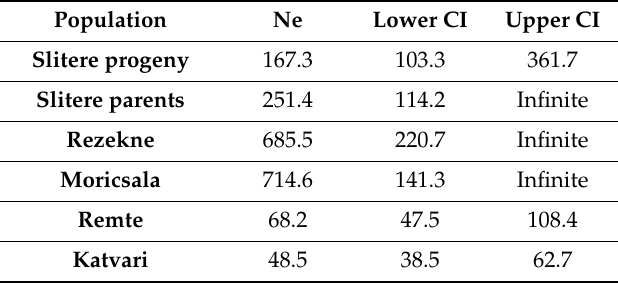
Table 4. E ff ective population size (Ne) of populations calculated using the linkage disequilibrium (LD) method, with upper and lower 95% confidence intervals